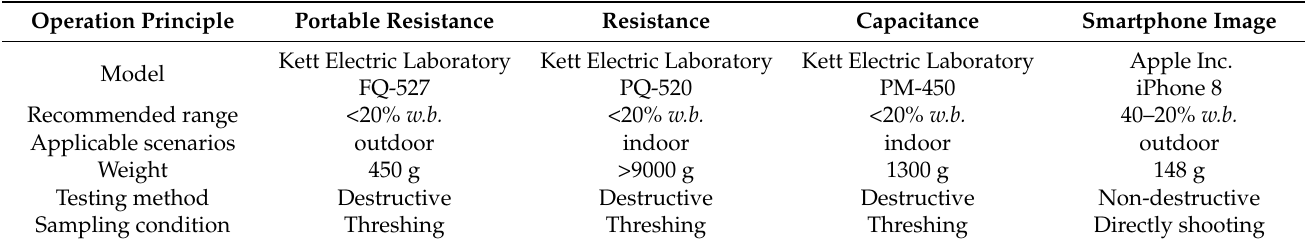
Table 5. Comparison of GMC sensors with various operation